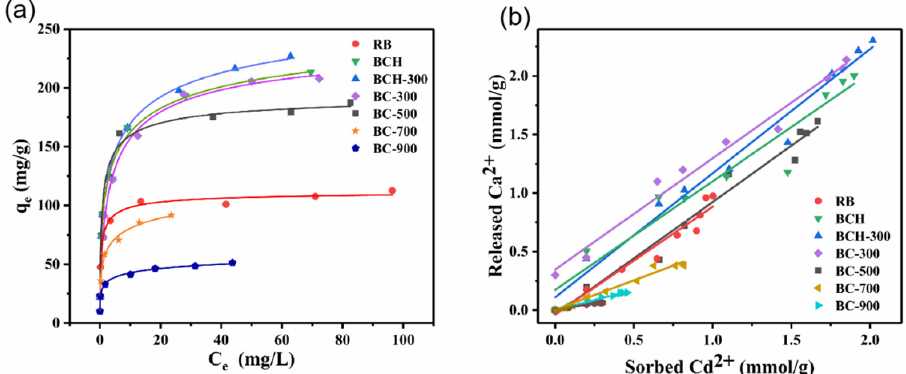
Figure 6. The Langmuir model fit of Cd 2+ adsorption on BC and BCH samples ( a ) and the relation- ships between Cd 2+ adsorption and Ca 2+ release ( b ).